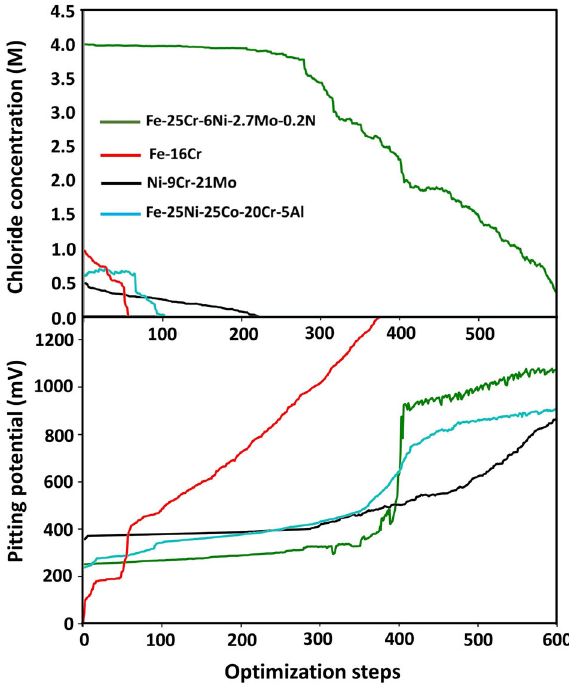
Fig. 2 Effect of chloride ion concentration. Variation in pitting potential (target variable) during the optimization, starting from different initial conditions and the corresponding change in chloride ion concentrations during the respective optimization sequence (the legend is applicable for both